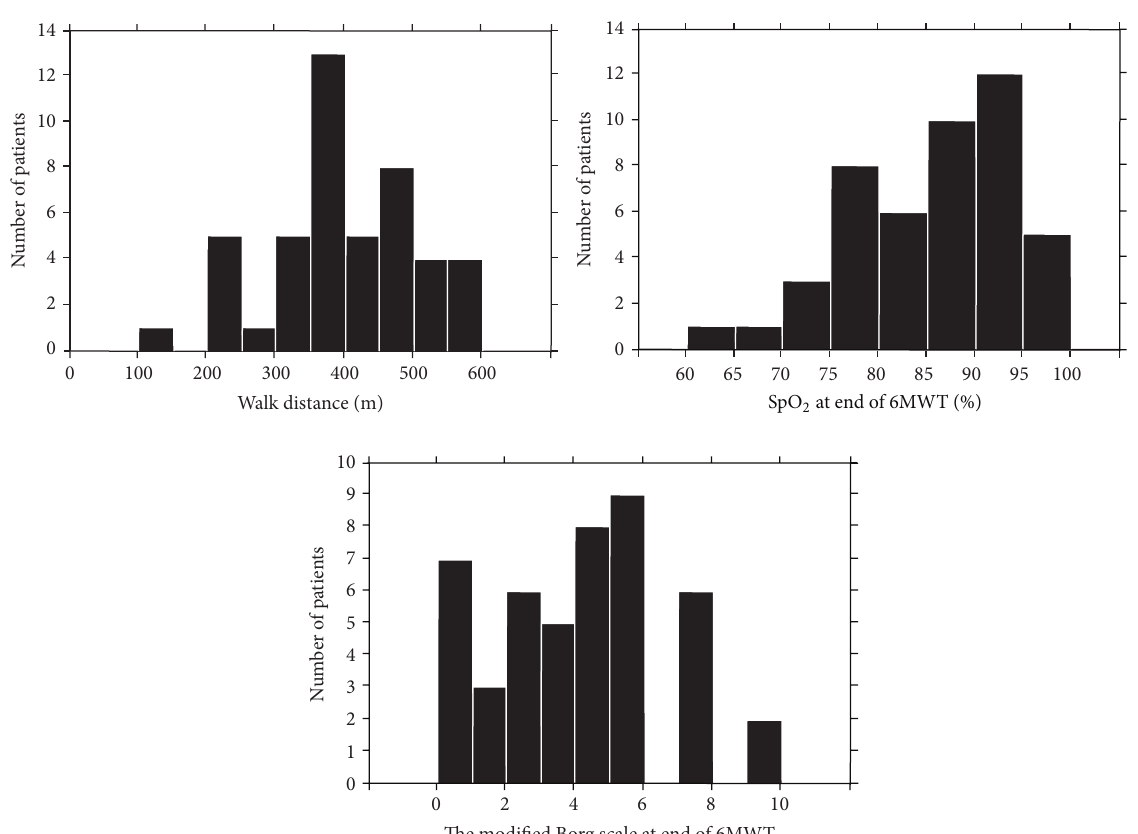
Figure 1: Histogram of patients for 6-min walk distance, SpO 2 at end of 6MWT, and dyspnea assessed with modified Borg scale at the end of the test. SpO 2 transcutaneous oxygen saturation; 6MWT: 6-min walk test.